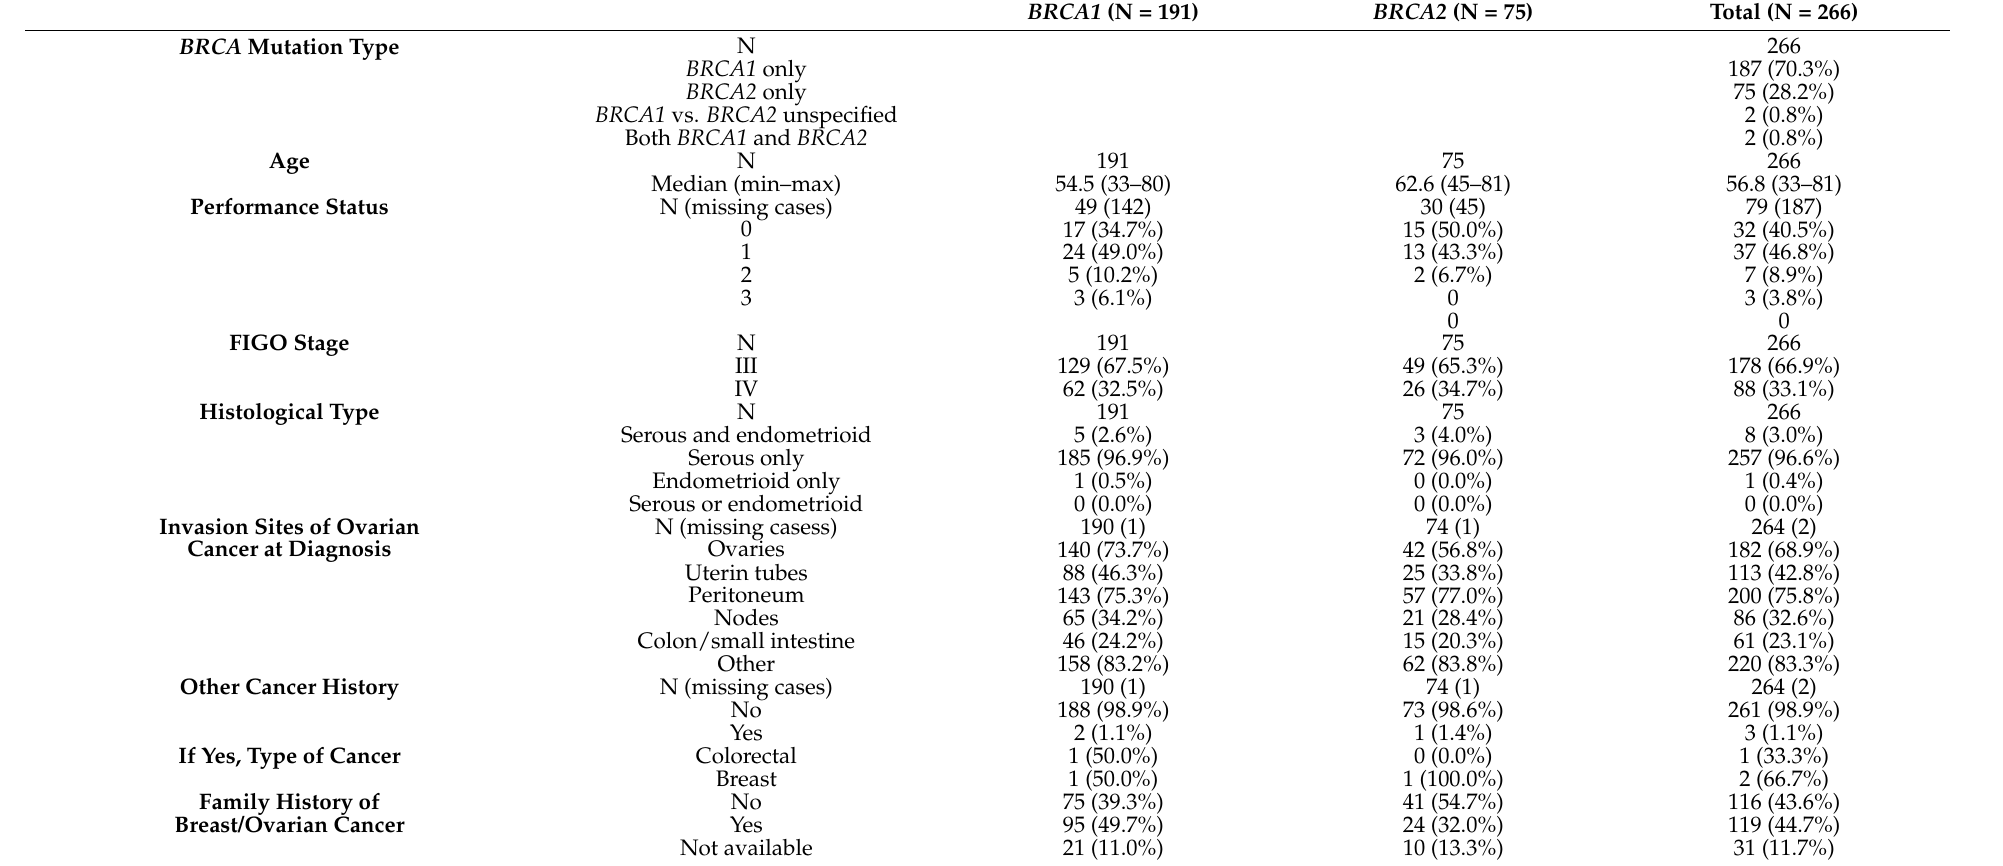
Table 1. Baseline